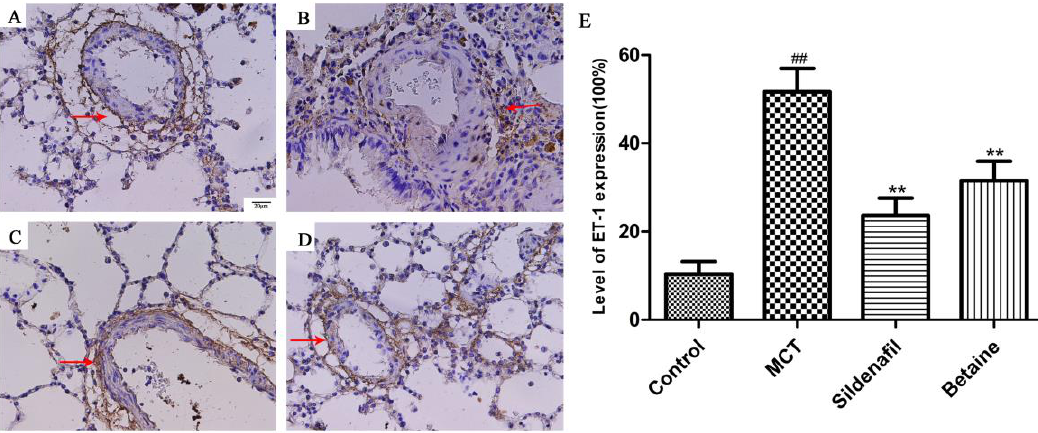
Figure 8. ( A – D ) Effects of betaine on the expression of ET-1 in lungs (magnification ×400). Data are shown as mean ± standard error of the mean ( n = 6). ## p < 0.01 vs control group; ** p < 0.01 vs MCT group. ( A ) Control group, ( B ) MCT group, ( C ) betaine 400 mg/kg group, ( D ) The bar graph reflects level of ET-1 expression.